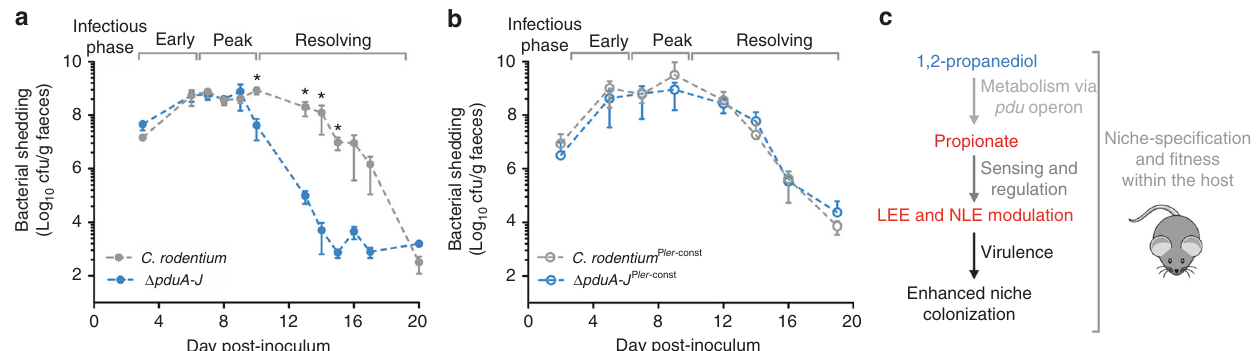
Fig. 6 1,2-propanediol regulated virulence is required for host colonization. a Colonization of mice host by wild type C. rodentium or Δ pduA-J (groups of n = 5). Each data point represents the mean bacterial load (±SEM) in faeces of infected mice (CFU/g). The infectious phase of each sampling point is indicated above the graph. Statistical signi fi cance between the strains at certain time points is indicated by a * denoting P ≤ 0.05 (Mann – Whitney U -test). b Colonization of mice host by C. rodentium P ler- const or Δ pduA-J P ler- const ( n = 10). Each data point represents the mean bacterial load in faeces of infected mice (CFU/g). c Schematic summary of how 1,2-propanediol metabolism regulates